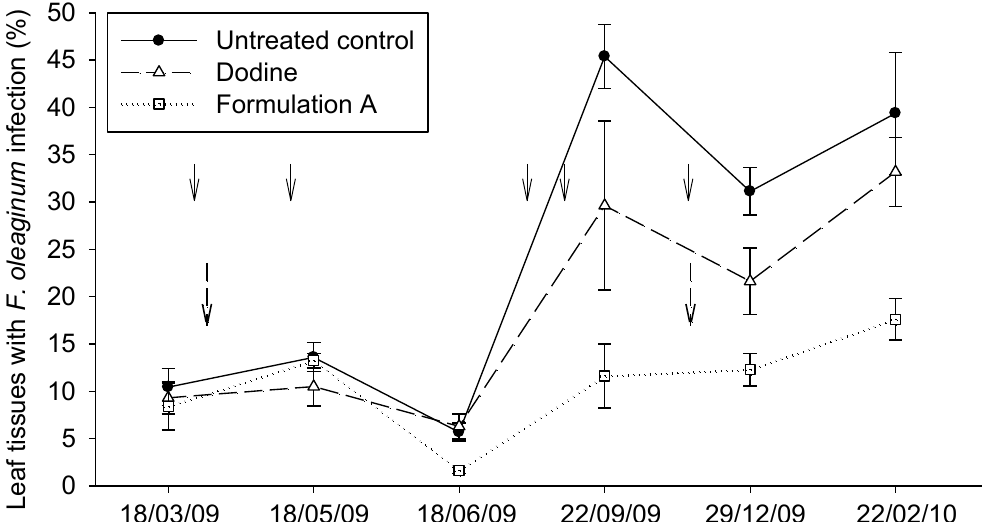
Figure 2. Mean proportions of olive leaf tissues with F. oleagineum infection in the cultivar Nocellara del Belice. Treatments with Formulation A and dodine are